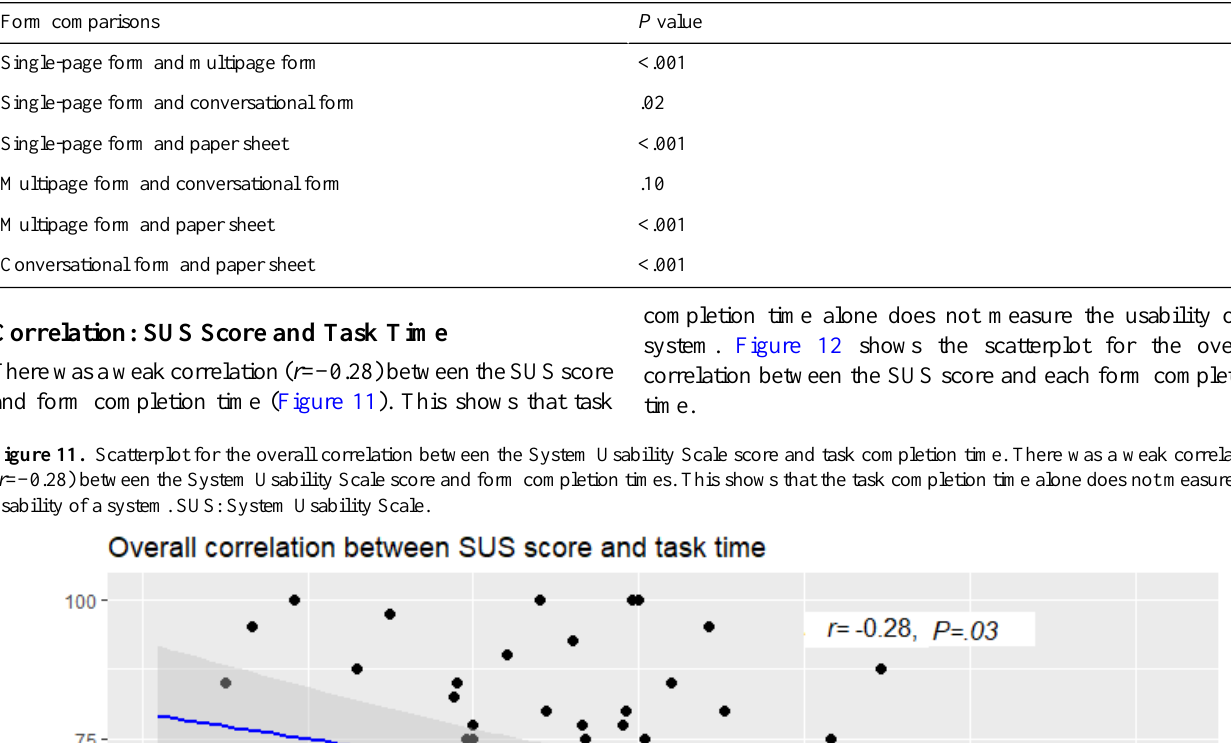
Table 2. P values between the completion time of all forms.